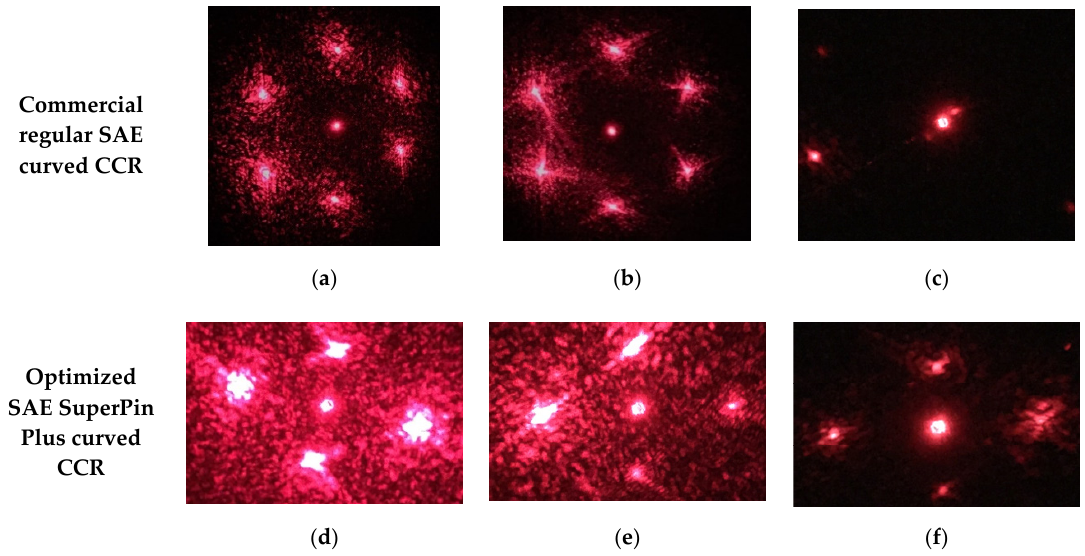
Figure 19. The intensity distributions on anterior, central, and posterior regions, which are shown in: